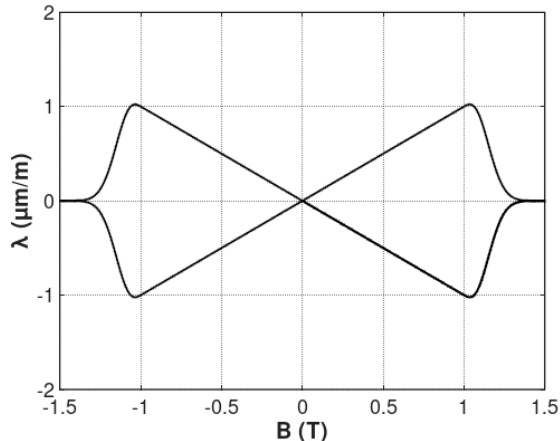
Figure 4. The flux density B dependence of magnetostrictive hysteresis λ hyst calculated for the following parameters: B switch = 1 T, k = 0.1, a hyst = 1 µ m